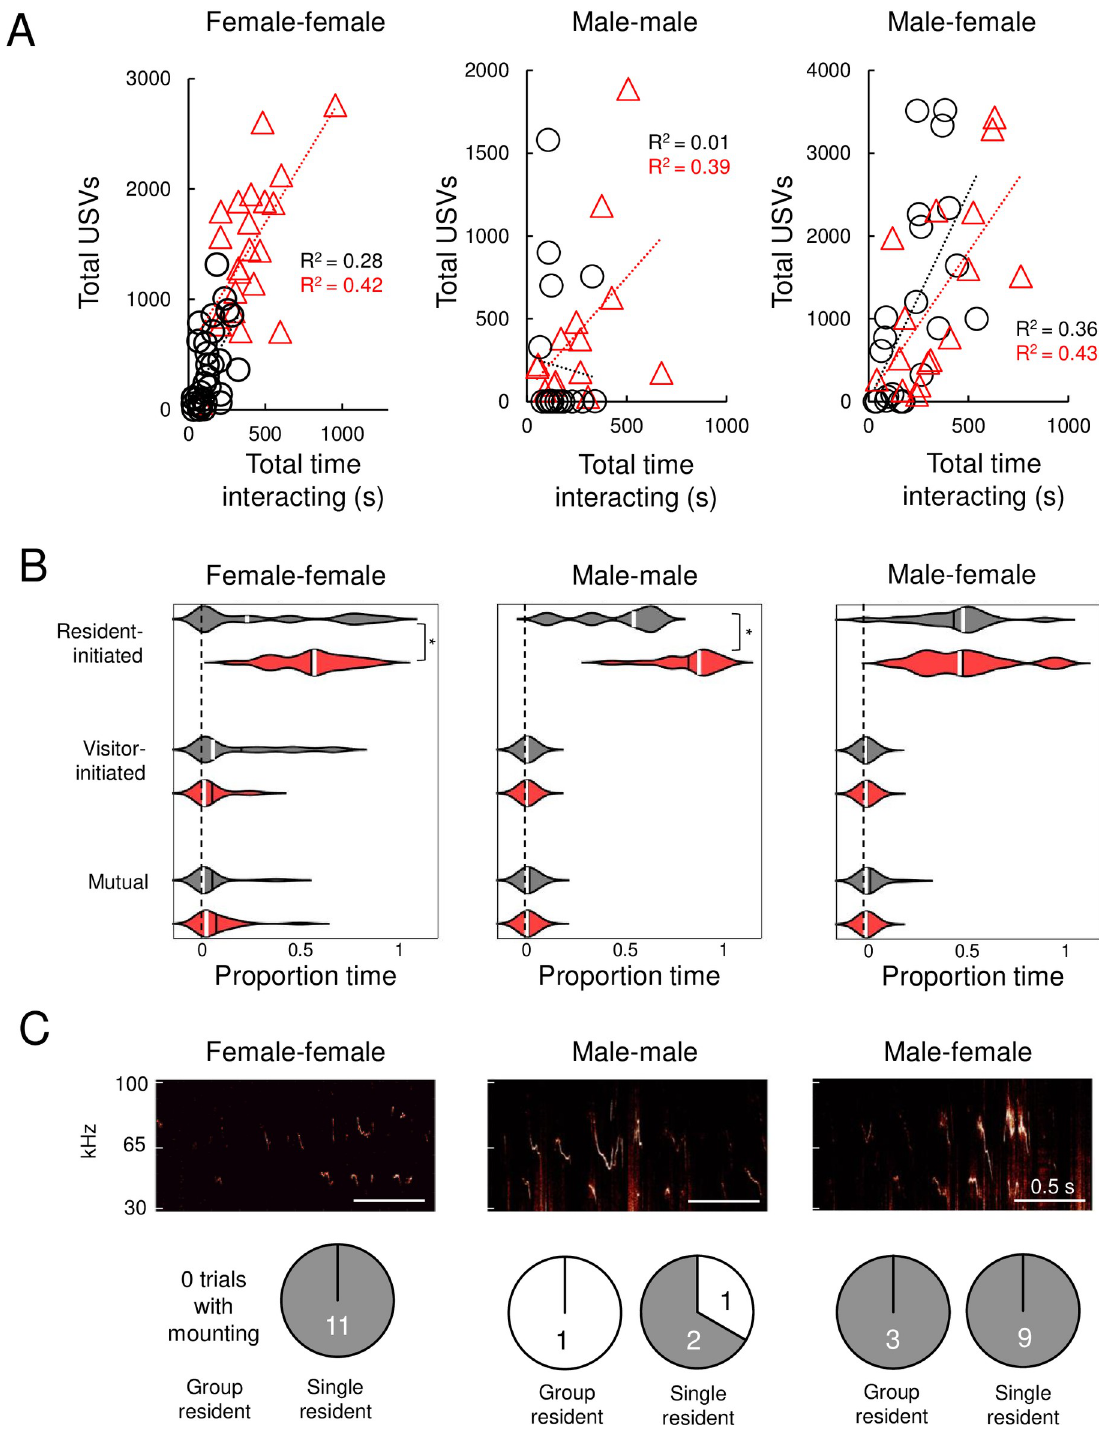
Fig 3. Effects of acute isolation on the relationship of USV production to non-vocal social behaviors. (A) Scatterplots show the number of USVs emitted versus the proportion total time spent interacting for female-female trials (left), male-male trials (middle), and male- female trials (right). Black symbols, trials with group-housed residents; red symbols, trials with single-housed residents. (B) Violin plots show the proportion of USVs produced during different types of behavior. Gray plots summarize data for trials with group-housed residents, red plots summarize data for trials with single-housed residents. White lines indicate median values, black lines indicate mean values. Asterisks, p < 0.05. (C) Spectrograms show USVs produced during mounting events during female-female (left), male-male